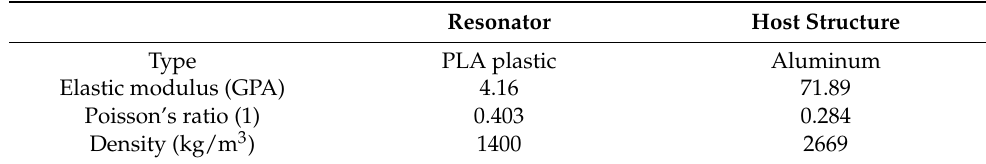
Table 2. Mechanical properties of the resonator and host structure.